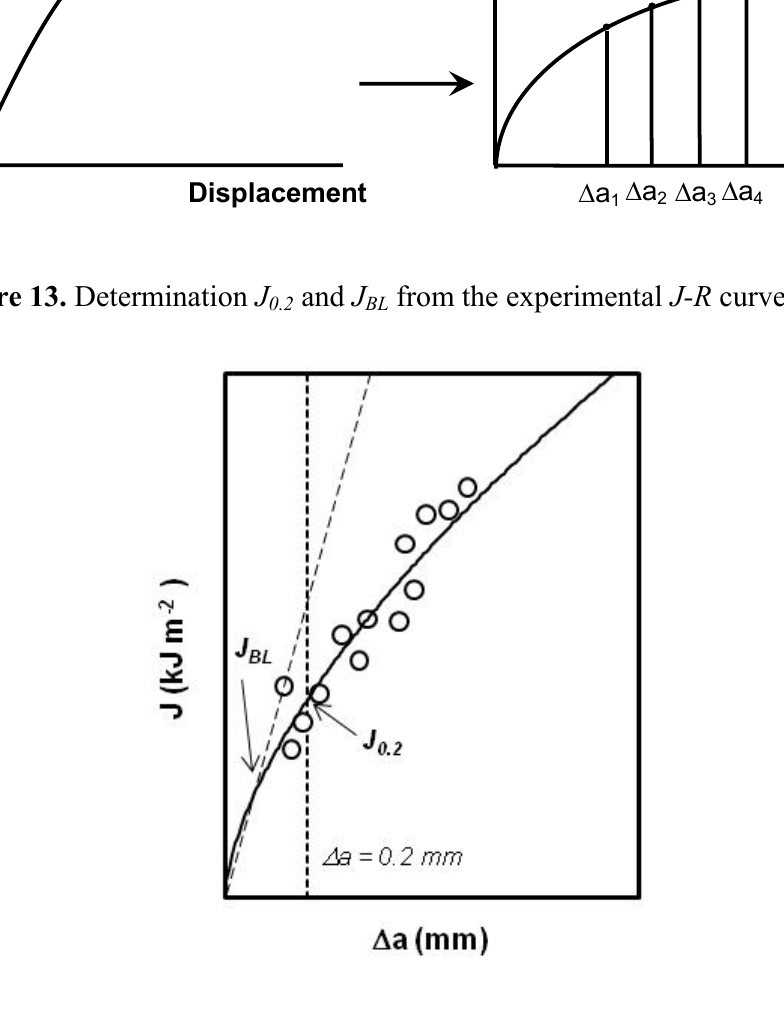
Figure 12. Construction of J-R curves from load-displacements curves obtained at different crack displacements.